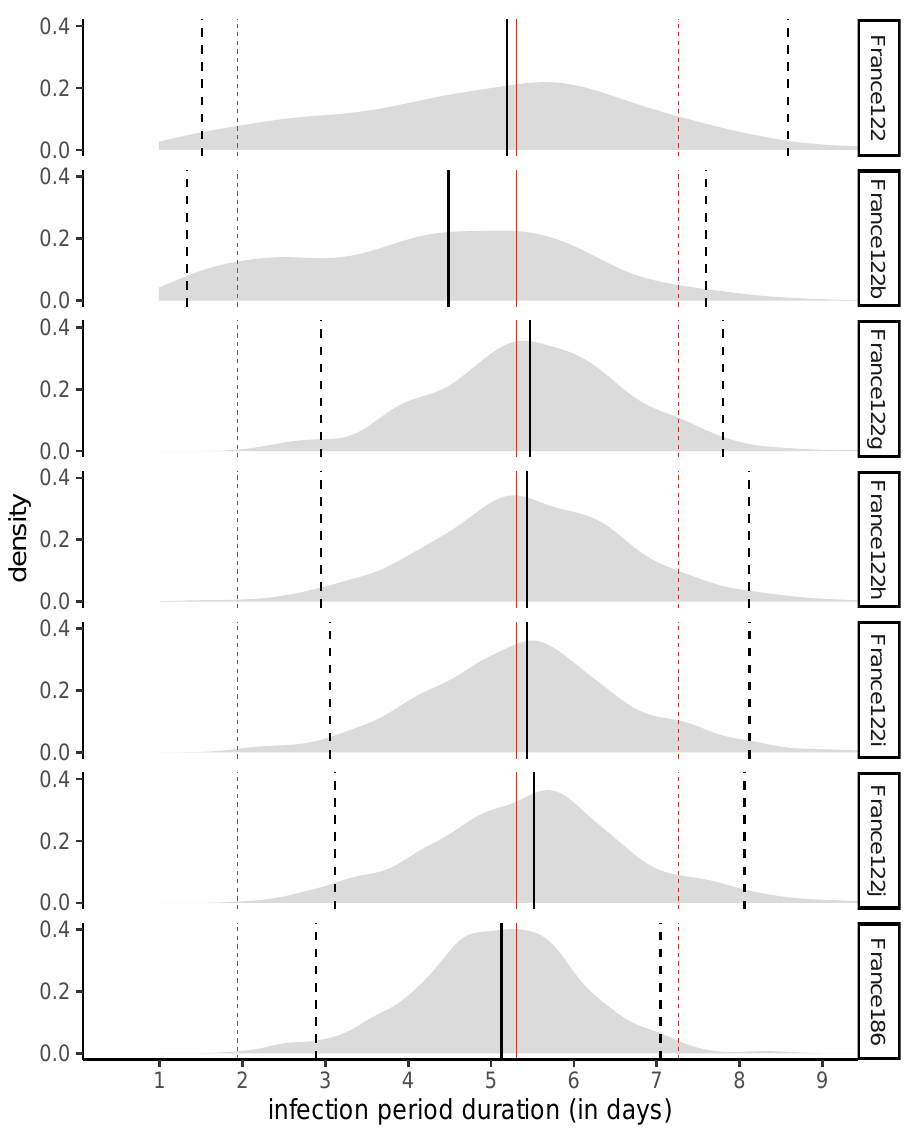
Figure S11 – Effective infection duration for the France186 dataset and subsets with 122 sequences assuming a BDSKY model. The median value obtained with the whole dataset (France186, black full line) is close to the average of the median values obtained with the subsets (red full